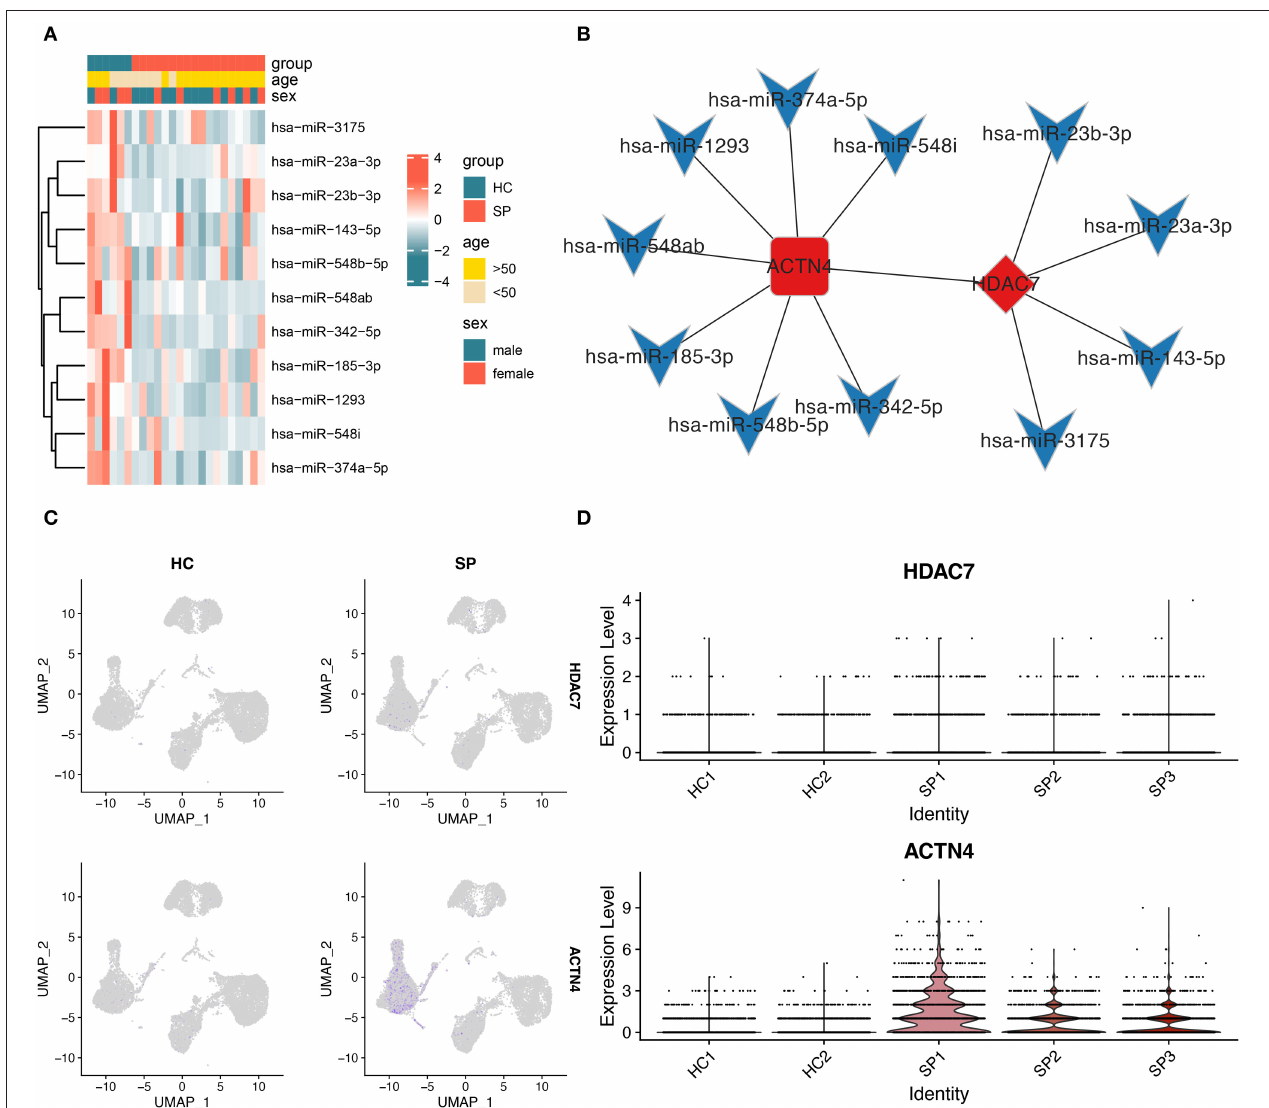
FIGURE 5 | Construction of the molecular interaction network. (A) Heatmap showing the expression of miRNAs in the molecular interaction network between HC and SP groups. (B) Molecular interaction network showing HDAC7 as the core TF and ACTN4 as the gene regulated by HDAC7. The diamond represents TFs, the round rectangle represents mRNAs, the V-shaped icon represents miRNAs, red bars indicate upregulated genes, and blue bars indicate downregulated genes. (C) Figure showing the expression of HDAC7 and ACTN4 between HC and SP groups. (D) Expression distribution of HDAC7 and ACTN4 between individual samples in single-cell data